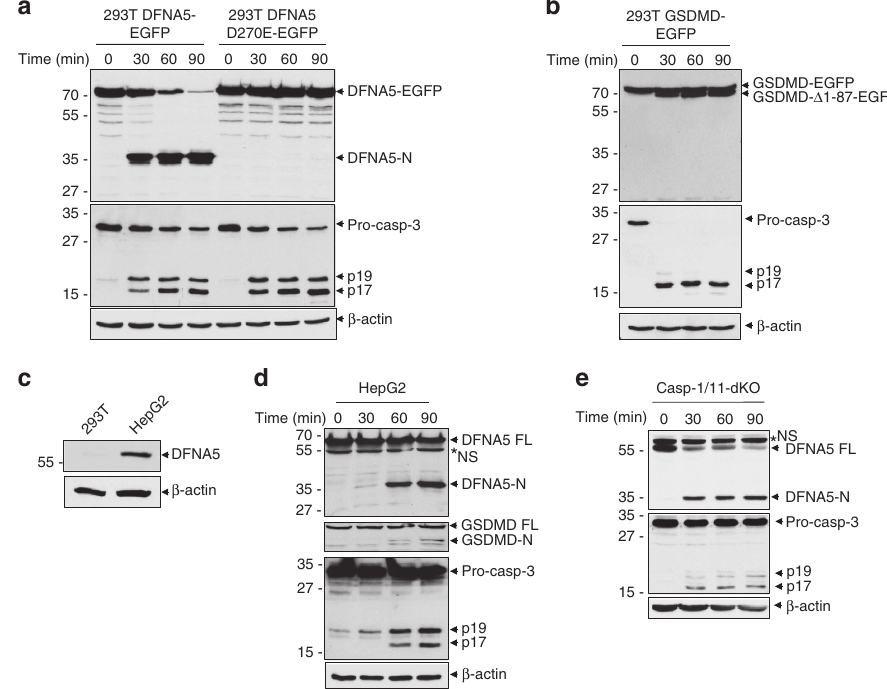
Figure 2 | DFNA5 is cleaved by caspase-3 downstream of the Apaf-1 apoptosome. ( a , b ) Immunoblots of S100 lysates from stable 293T-DFNA5-EGFP and 293T-DFNA5-D270E-EGFP cells ( a ), or stable 293T-GSDMD-EGFP cells ( b ) stimulated with cytochrome c for the indicated times at 37 (cid:2) C. The blots were probed with anti-DFNA5 ( a , upper), anti-GSDMD ( b , upper), anti-caspase-3 ( a , b , middle) or anti- b -actin ( a , b , lower) antibodies. ( c ) Immunoblot of endogenous DFNA5 in 293T and HEPG2 total cell lysates. ( c , d ) Immunoblots of S100 lysates from human HEPG2 ( d ) or mouse casp-1/casp-11-double knockout (casp-1/11-dKO) ( e ) macrophages stimulated with cytochrome c for the indicated times at 37 (cid:2) C. The blots were probed with anti-DFNA5 (upper in d , e ), anti-GSDMD (second from top in d ), anti-caspase-3 (third from top in d , middle in e ) or anti- b -actin (fourth from top in d , lower in e ) antibodies. Asterisk indicate non-specific band (NS). Results are representative of at least three independent